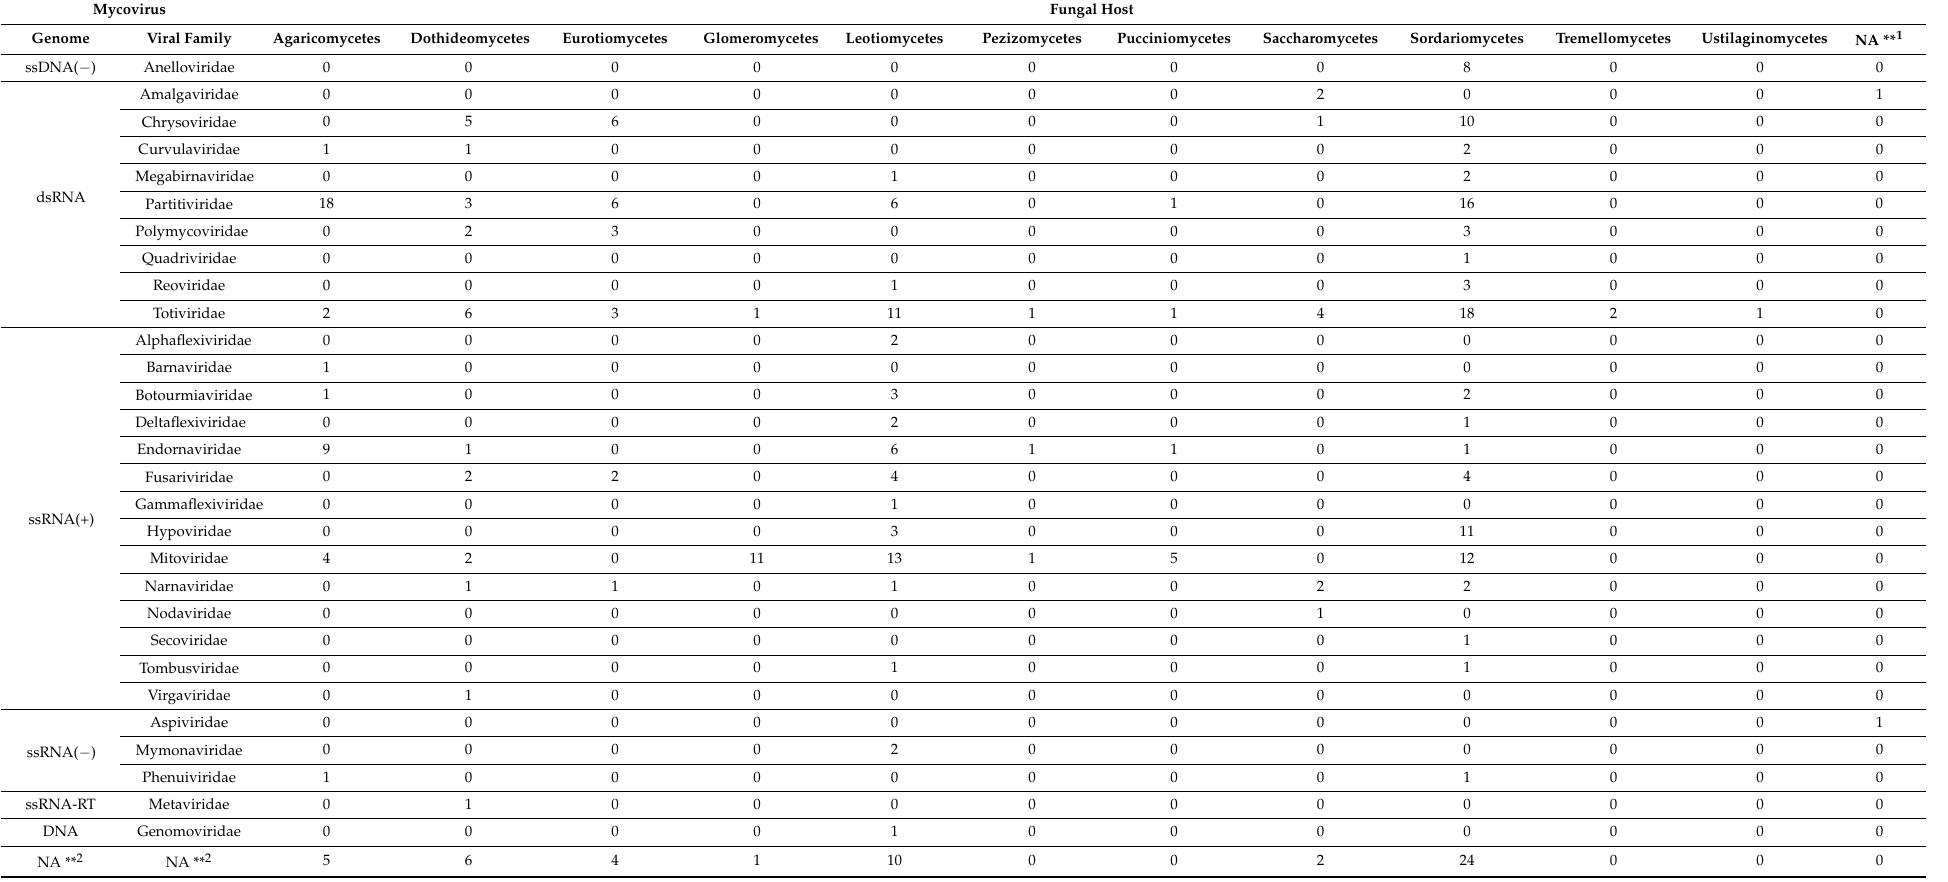
Table 1. Frequency counts * of known viral families infecting major fungal classes, grouped by viral genome. Data source: ICTV Master Species List 2020. Mycovirus